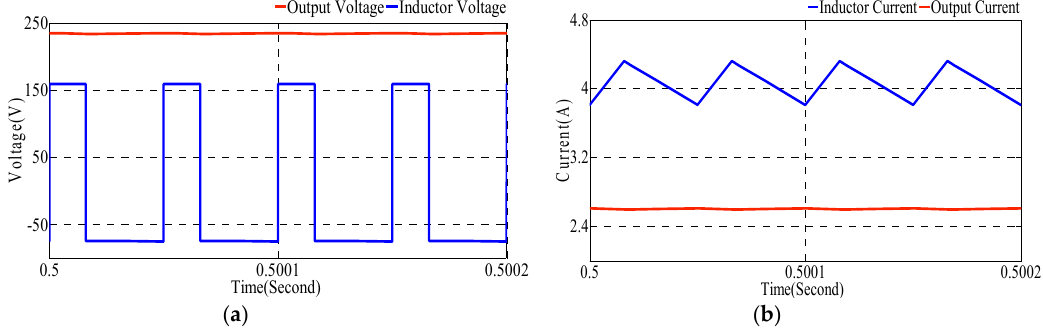
Figure 10. Simulation waveforms of the MBDC converter in boost operation: ( a ) Output voltage and